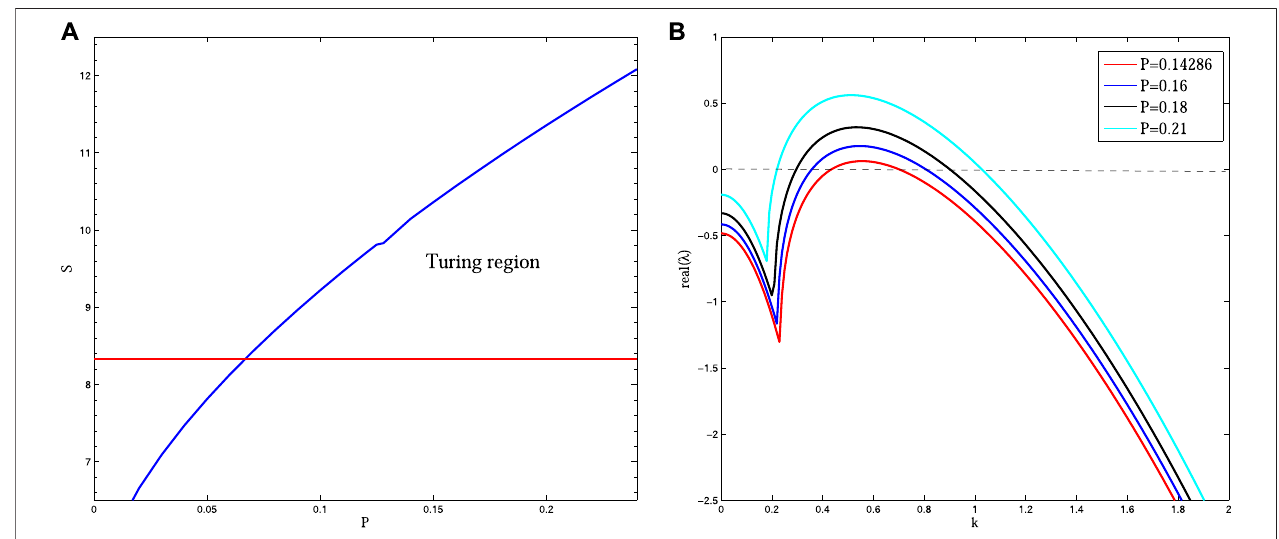
FIGURE2| (Coloronline) (A) Thebifurcationdiagramforsystem(3)in P — S plane.InTuringregion,Turingpatternwillform. (B) Dispersionrelationofsystem(3)with different P , other parameter values are taken as: S (cid:1) 10, B (cid:1) 5, D (cid:1) 30, which reveals that the real-part of eigenvalues R ( λ ) increases with P increasing.